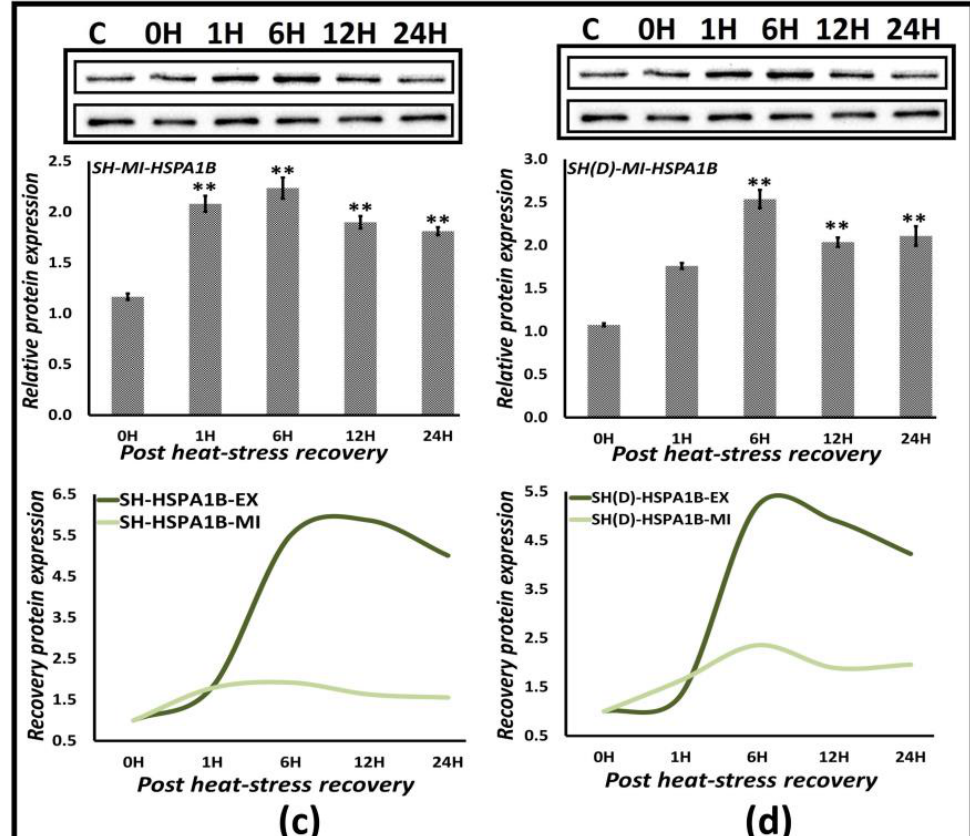
Figure 7. Protein expression during extreme and mild heat stress. ( a , b ): HSPA6; ( c , d ): HSPA1B in SH-SY5Y [SH] and differentiated SH-SY5Y [SH(D)] cells. The bar graphs represent the quantification